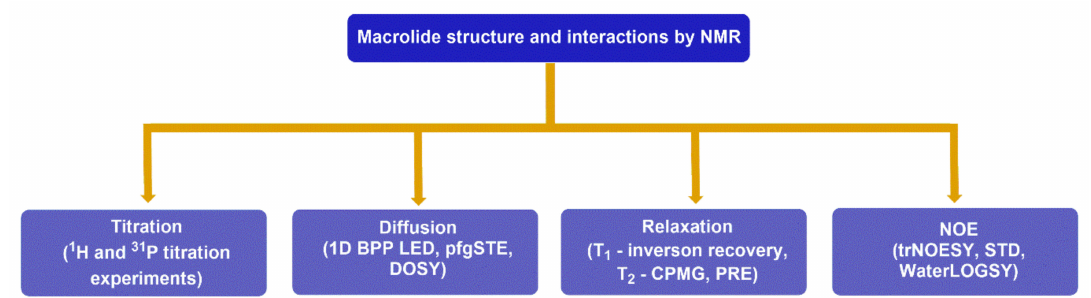
Figure 5. NMR experiments frequently used for studying the structure and interactions of